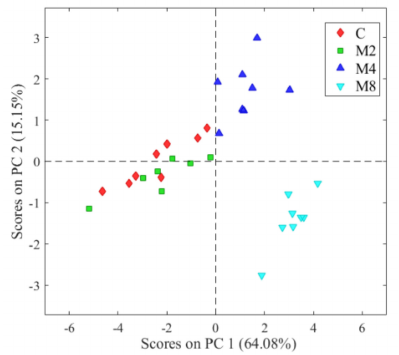
Figure 1. Score plot obtained from the PCA of olives stuffed with flavoured hydrocolloids at different concentrations. C: Spanish-style green table olives without aroma; M2: Spanish-style green table olives with ‘Mojo pic ó n’ flavour at 2%; M4: Spanish-style green table olives with ‘Mojo pic ó n’